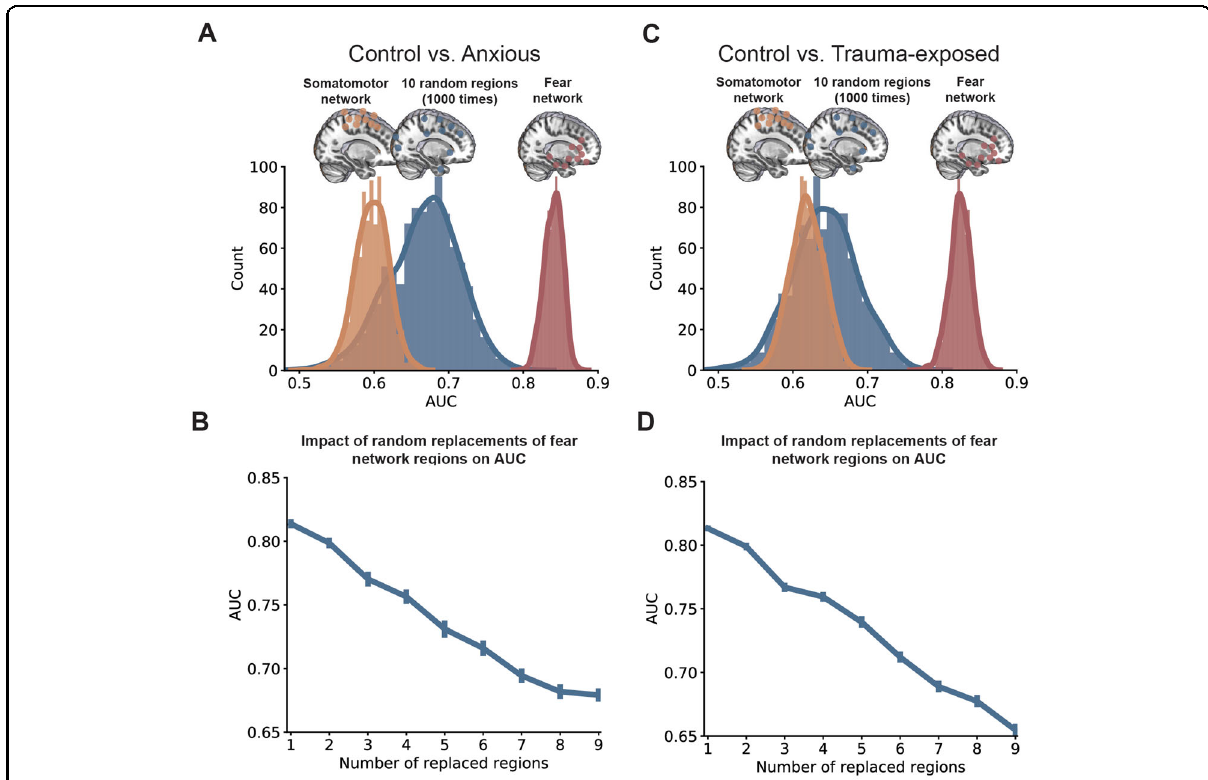
Fig. 4 Speci fi city analysis of the fear network in classi fi cation. A Distribution of AUCs based on brain activations within the 10-node fear network, or 10 regions within the somotomotor network, or 10 randomly selected brain regions for Controls vs. Anxious. B Mean AUCs were shown when a speci fi c number of regions within the fear network were replaced by a mathced number of randomly selected brain regions for Controls vs. Anxious. C , D Corresponding analyses for Controls vs.